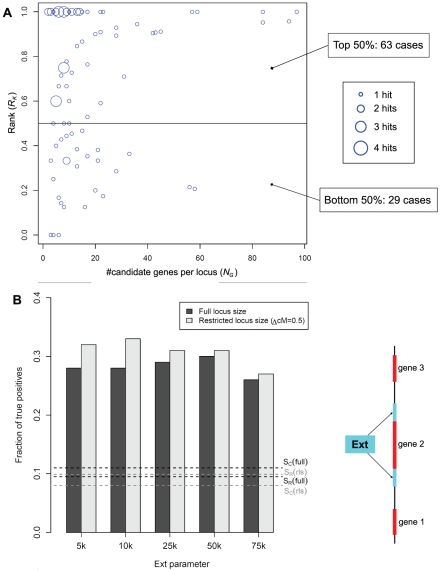
Integration of MDP and BXD eQTL data for fine mapping.
A: Distribution of the ranking results for 105 selected eQTL intervals with strong association signals in both the BXD and MDP datasets. The x-axis shows the number of candidate genes at each locus and the y-axis shows the rank (scaled between 0 and 1) of genes that are in common pathways with the target genes. Thus, each eQTL interval is represented as a point of coordinates (RK, NG) where RK is the rank of the (presumed) causal gene from the KEGG pathway and NG is the number of genes within the interval. Circle sizes are proportional to the number of eQTL. Pathway co-members rank significantly above random when using the MDP data as additional information for scoring candidate genes. B: Assessment of MDP-based candidate gene selection. For each of the 105 selected loci a selected candidate gene was considered as a true positive if it is part of a common pathway with the target gene. The figure shows the fraction of loci with correct selections. Bars show results when ranking genes based on their MDP scores for different values of the ext parameter (see schema on the right), using full locus and restricted locus sizes (i.e. loci are restricted to 0.5 cM around the BXD marker). Horizontal lines show true positive rates for random selections (SR) and selecting the closest gene (SC). Black lines: ‘closest gene’ success rate (SC) and random success rate (SR) for full locus sizes. Grey lines: SC and SR for restricted locus sizes (rls).